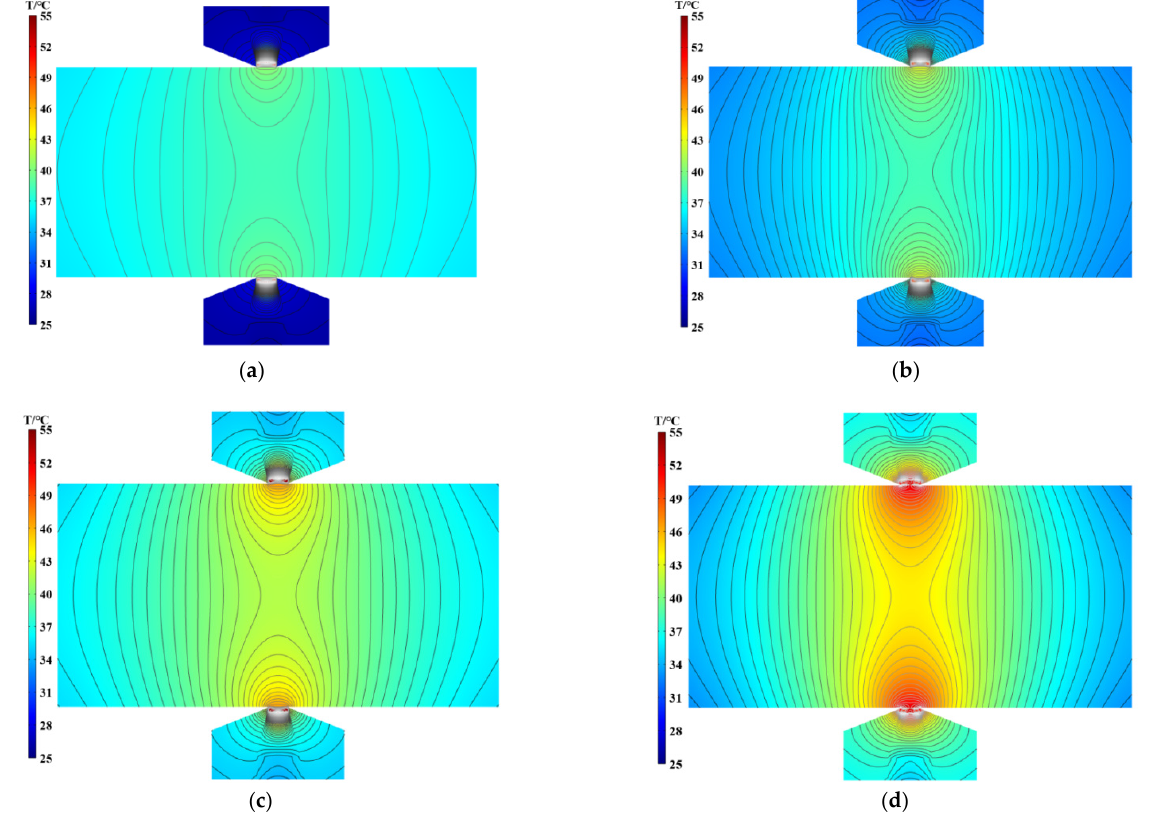
Figure 8. Temperature cloud of the MR fluid seal at different speeds with H = 0: ( a ) 300 rpm; ( b ) 600 rpm; ( c ) 900 rpm; and ( d ) 1500 rpm.